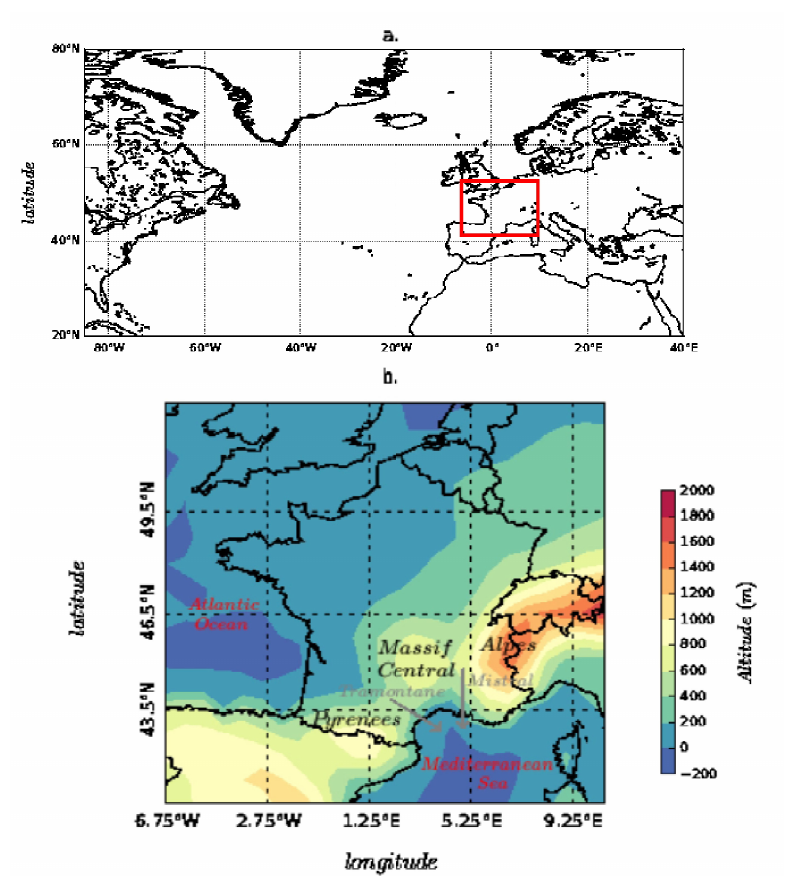
Figure 2. ( a ) North Atlantic/European domain from where the 500-hPa geopotential height Z 500 is retrieved. The red box corresponds to the domain in panel b. ( b ) Domain covering France and part of its neighbouring countries. The colors represents the topography and